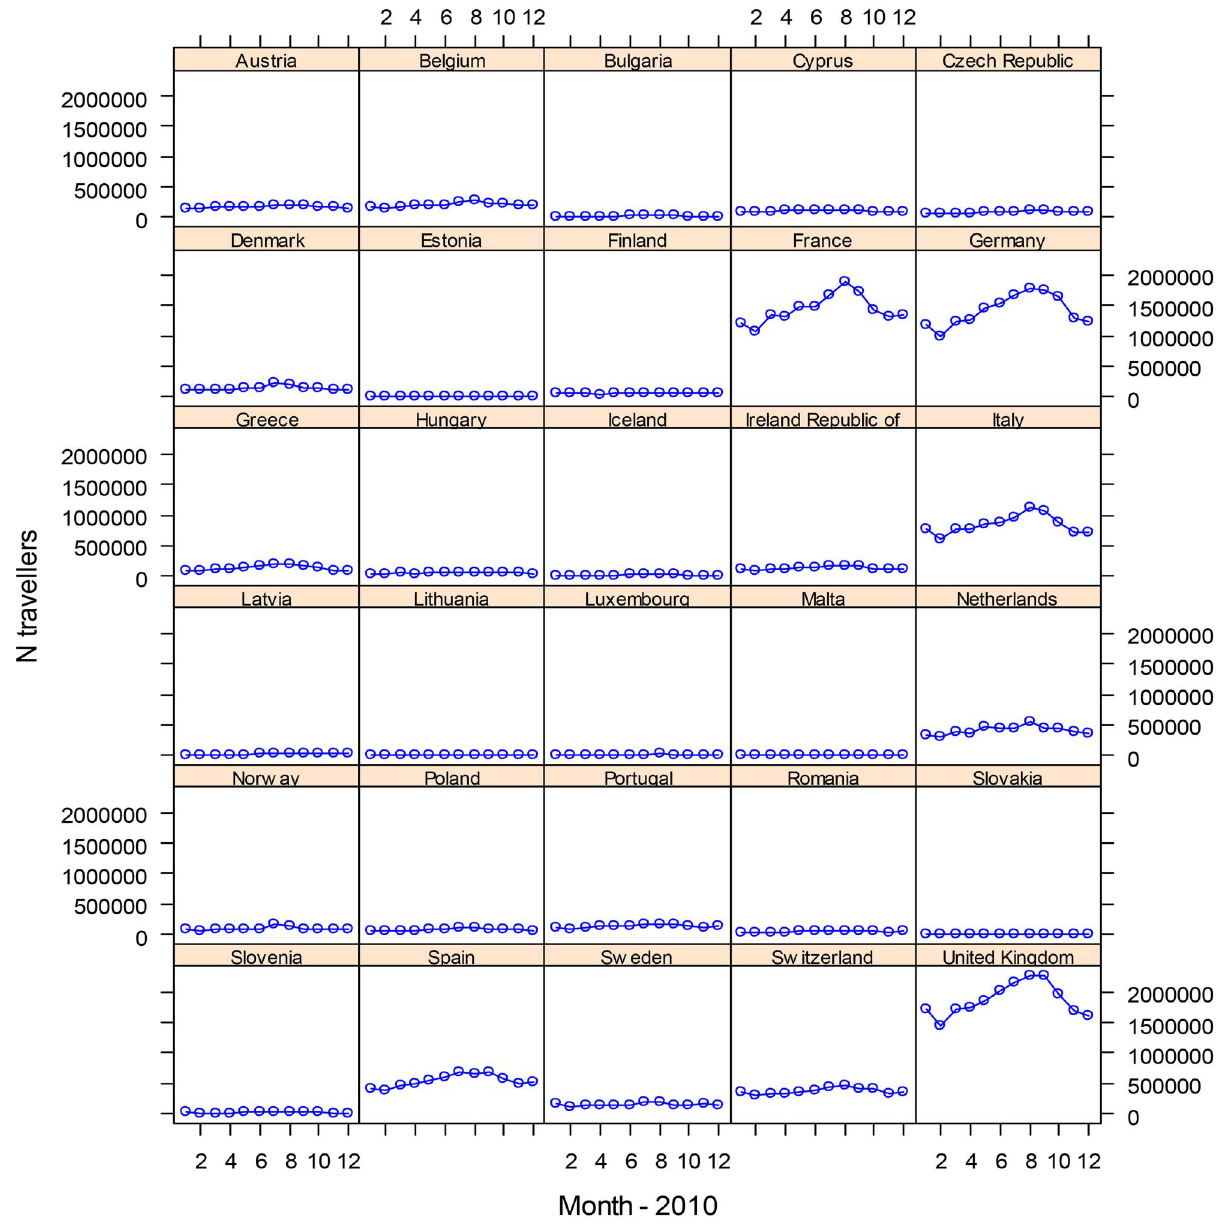
Figure 1. Number of international air travellers arriving in the EU, by country and month, 2010.